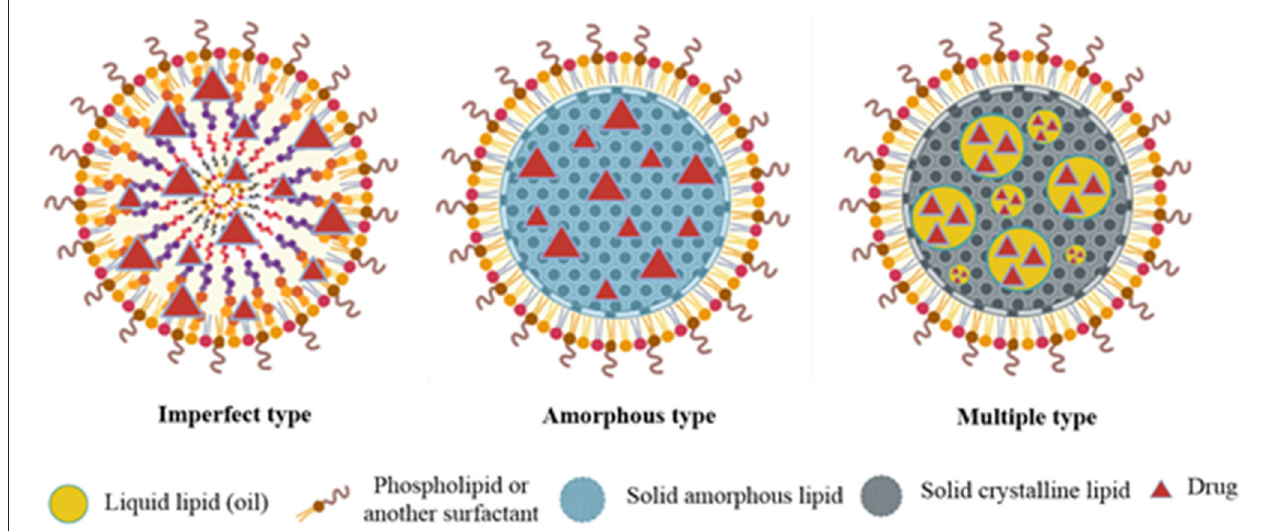
FIGURE 5 | Diagrammatic presentation of imperfect, amorphous, and multiple type